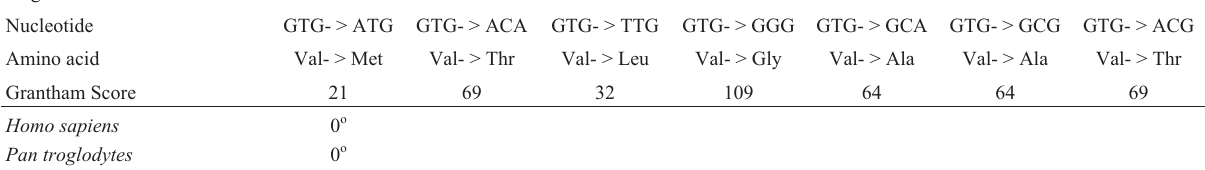
Table 3 - FOXP3 Linear motifs changes in Mammals, as predicted by ELM. Aligned Position